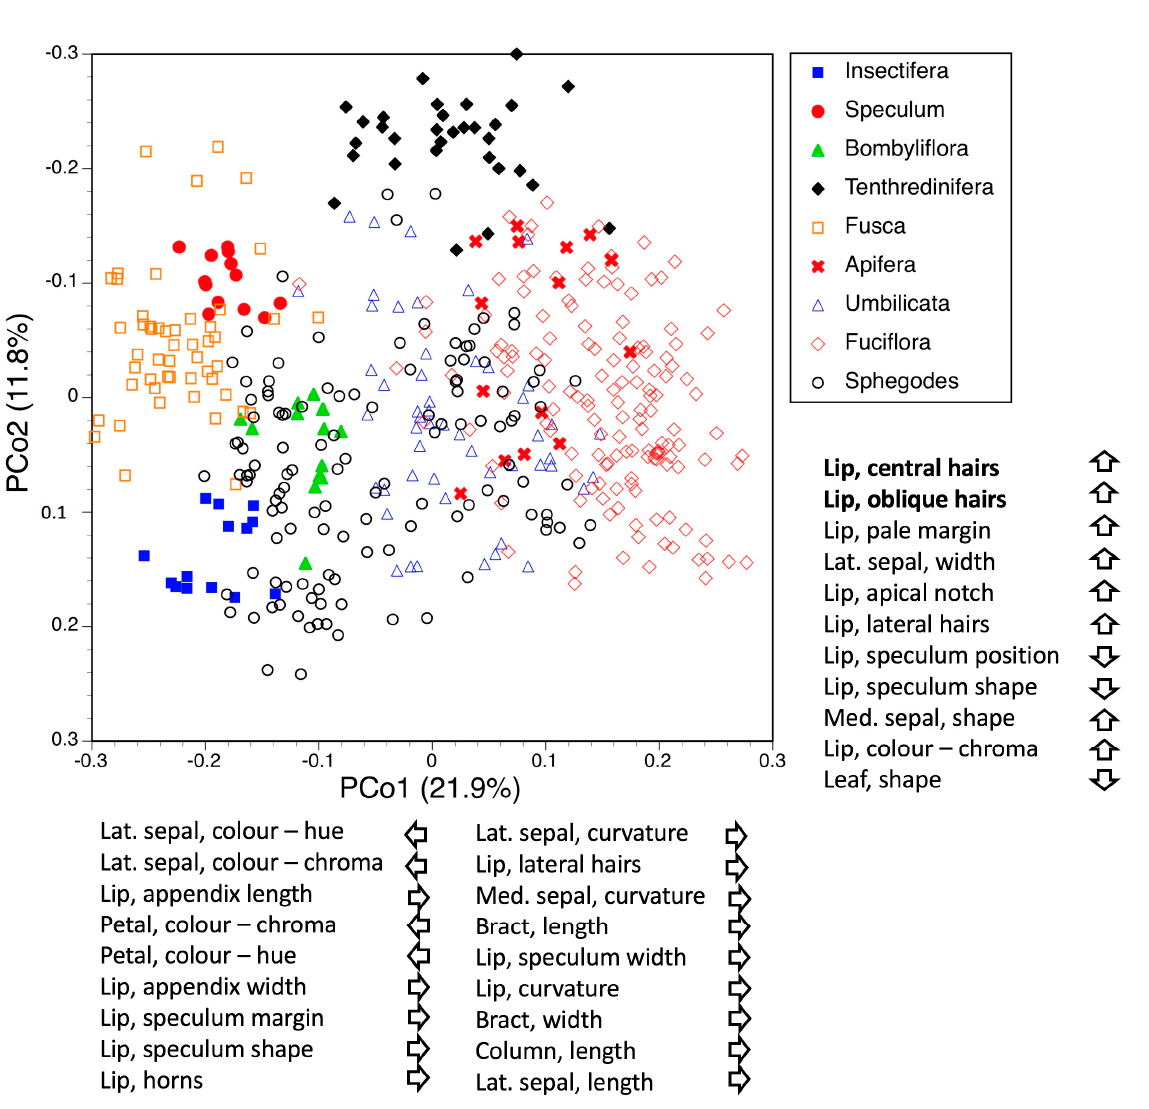
Figure 5. Plot of principal coordinates 1 and 2 for the genus Ophrys , labelled according to nine macrospecies groups: 447 individuals from ca . 300 localities, 51 variable characters. Characters contributing to each coordinate are listed in descending order, with arrows indicating the direction of increase in the value of each character (boldface characters dominate that coordinate).